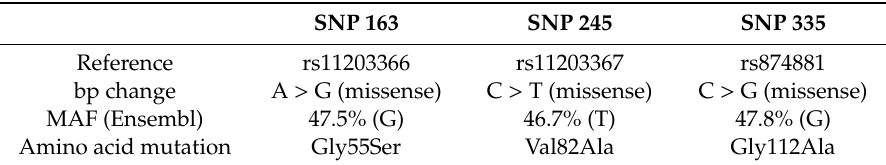
Table 1. Characteristics of the three most common single nucleotide polymorphisms (SNPs) of the PADI4